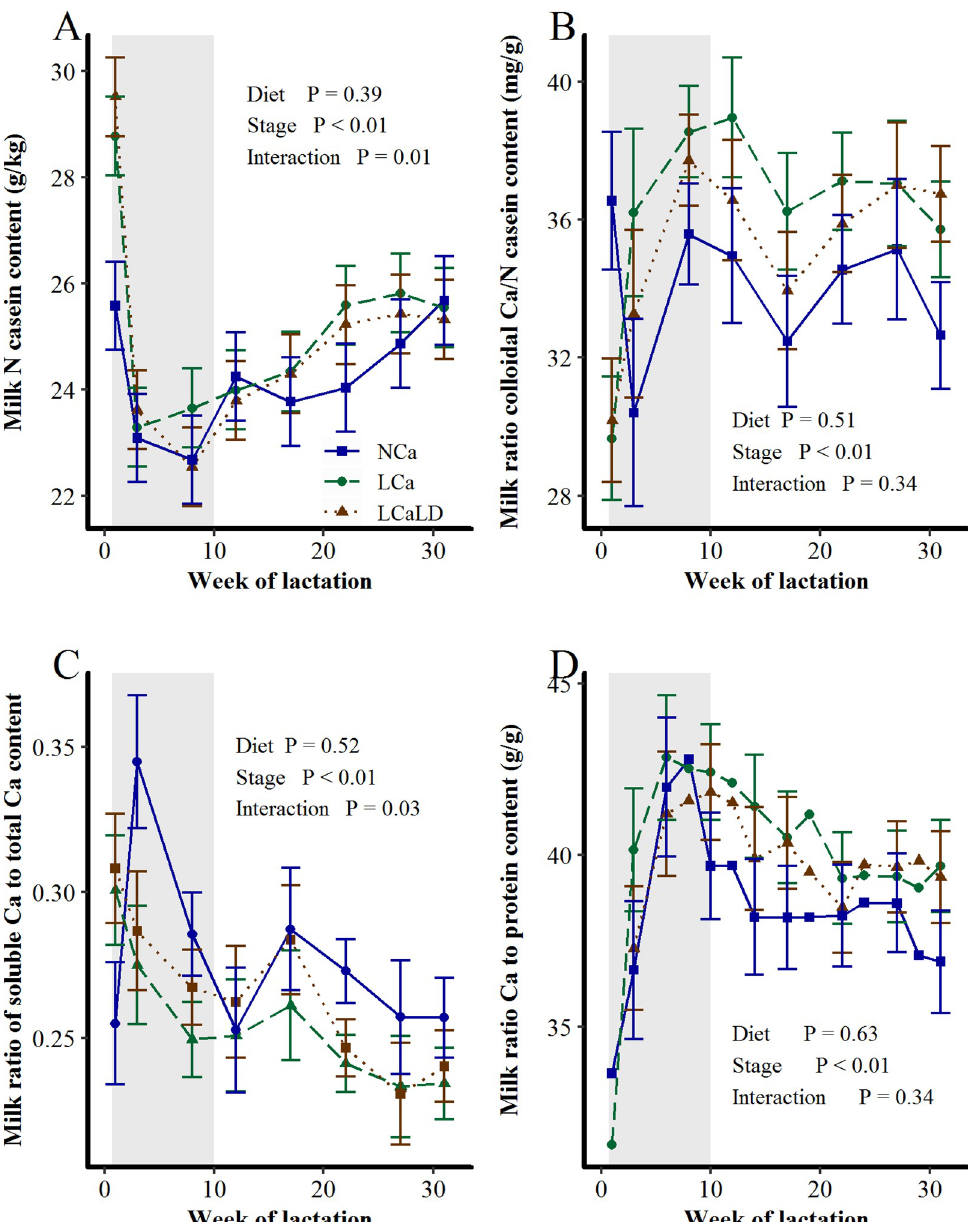
Fig 6. Effect of transient variation in dietary Ca content and the DCAD on the morning milk A) casein content, B) ratio of colloidal Ca to casein content, C) ratio of soluble Ca to total Ca content and D) ratio of Ca to protein content between calving and 32 weeks of lactation. NCa = normal Ca (4 cows), LCa = low Ca (5 cows), LCaLD = low Ca and low DCAD (5 cows). Gray background specifies the period during which cows were fed differentiated diets according to the treatments. Data were analyzed using a generalized linear mixed model with repeated values using PROC GLIMMIX in SAS [35]. Covariance matrix: SP for milk casein content, un for milk ratio of colloidal Ca to casein content and FA for ratios of soluble to total Ca content and Ca to protein content. Vertical bars represent standard errors of the mean. Standard errors are shown for every two measurements for the milk Ca to protein content ratio for readability.